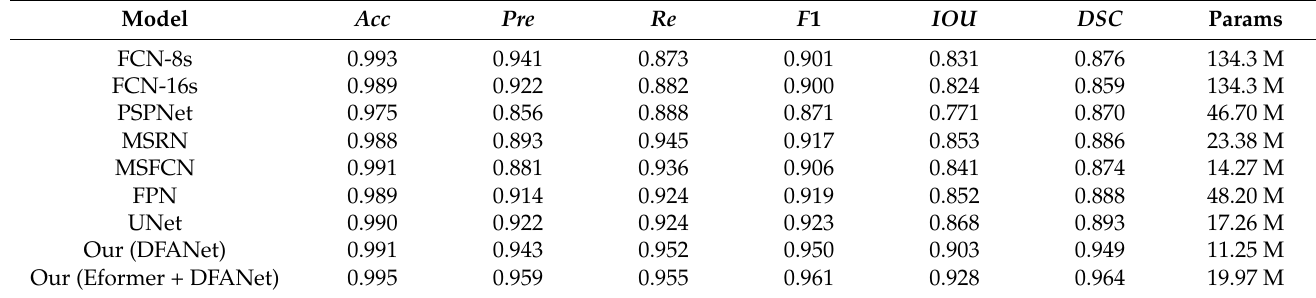
Table 4. Comparison of osteosarcoma segmentation performance of different algorithms. Figure 11. Our model has better performance than other models in each evaluation Model Acc Pre